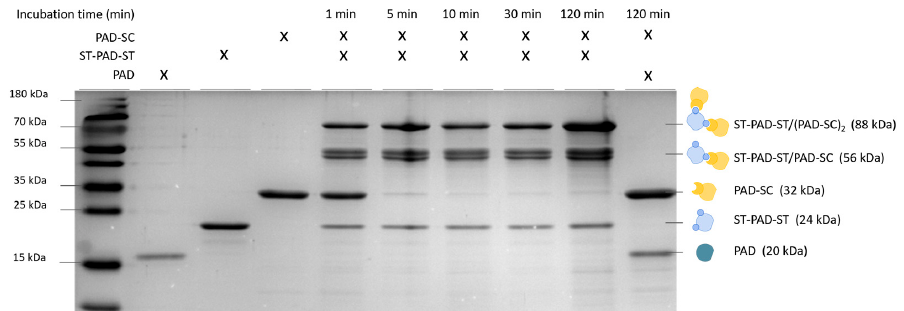
Figure 5. Kinetic analysis of the ST/SC ‐ conjugation of ST ‐ PAD ‐ ST and PAD ‐ SC analyzed by coomassie stained 16% SDS-PAGE. Stoichiometric amounts (30 pmol) of both enzymes were incubated for up to 2 h at 30 ◦ C. The reaction was stopped by the addition of 4 × SDS-PAGE loading bu ff er and heat